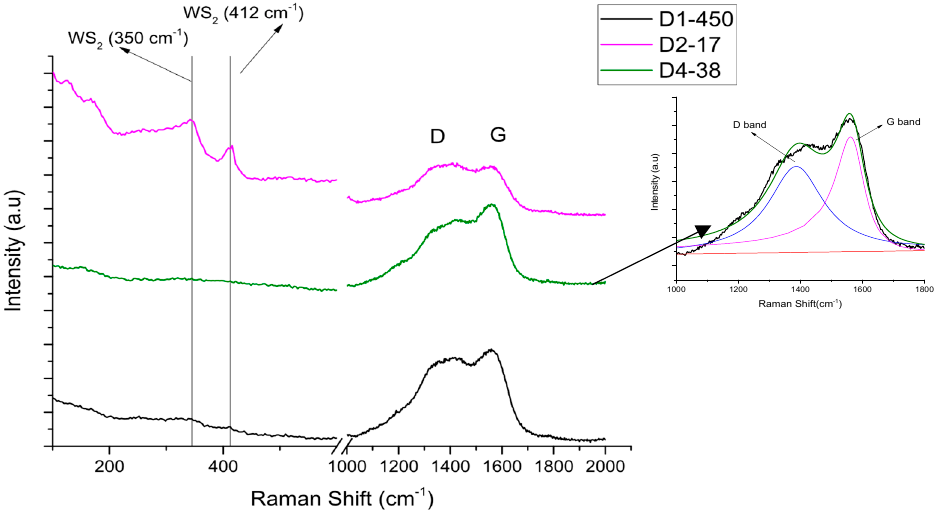
Figure 7. Raman spectra acquired from representative coatings.